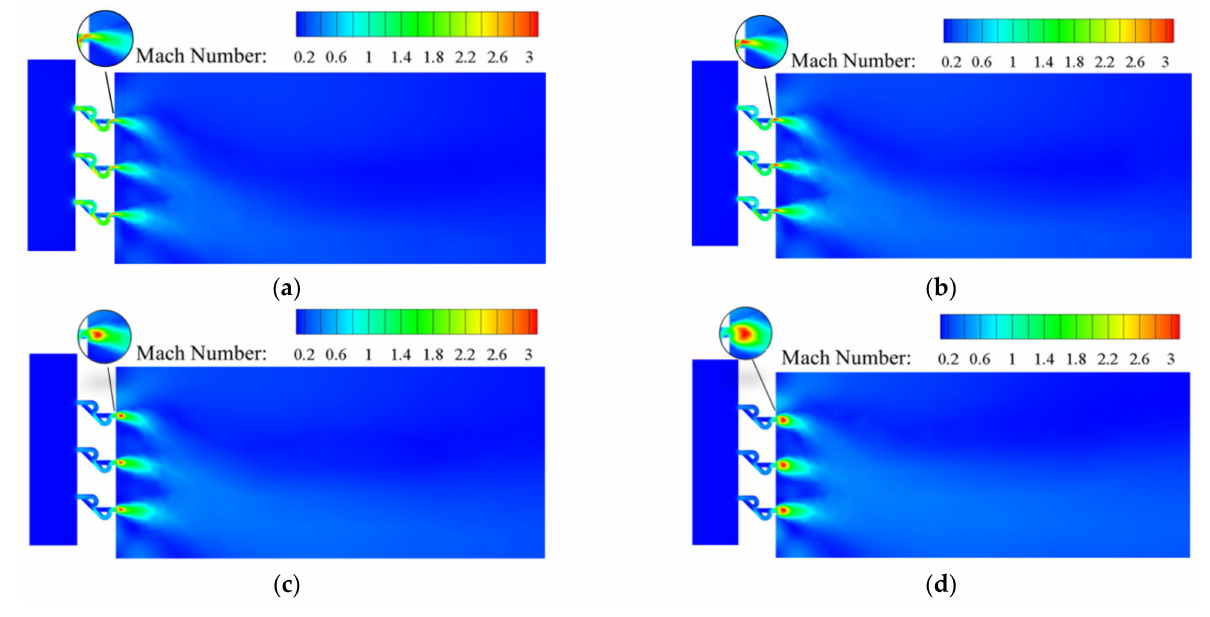
Figure 10. Mach number distribution on the symmetry plane for Tesla-type orifice structure un- der different mass flow rates. ( a ) Q m = 0.02 kg s − 1 . ( b ) Q m = 0.1 kg s − 1 . ( c ) Q m = 0.5 kg s − 1 . ( d ) Q m = 1 kg s − 1 .